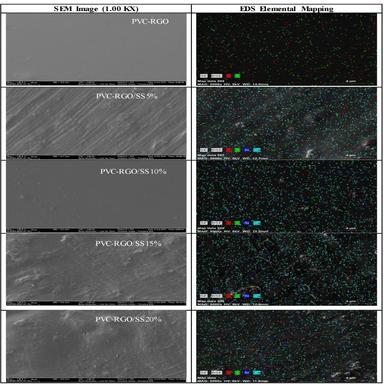
SEM images and EDS elemental mapping of PVC-RGO composite and SS reinforced PVC-RGO biocomposites.